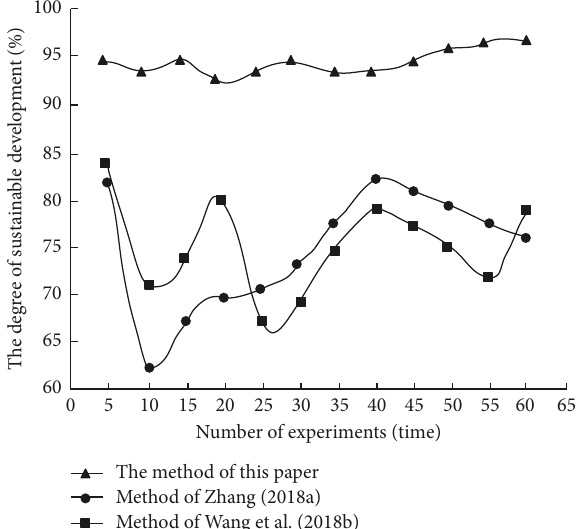
Figure 4: The degree of sustainable development under different methods.